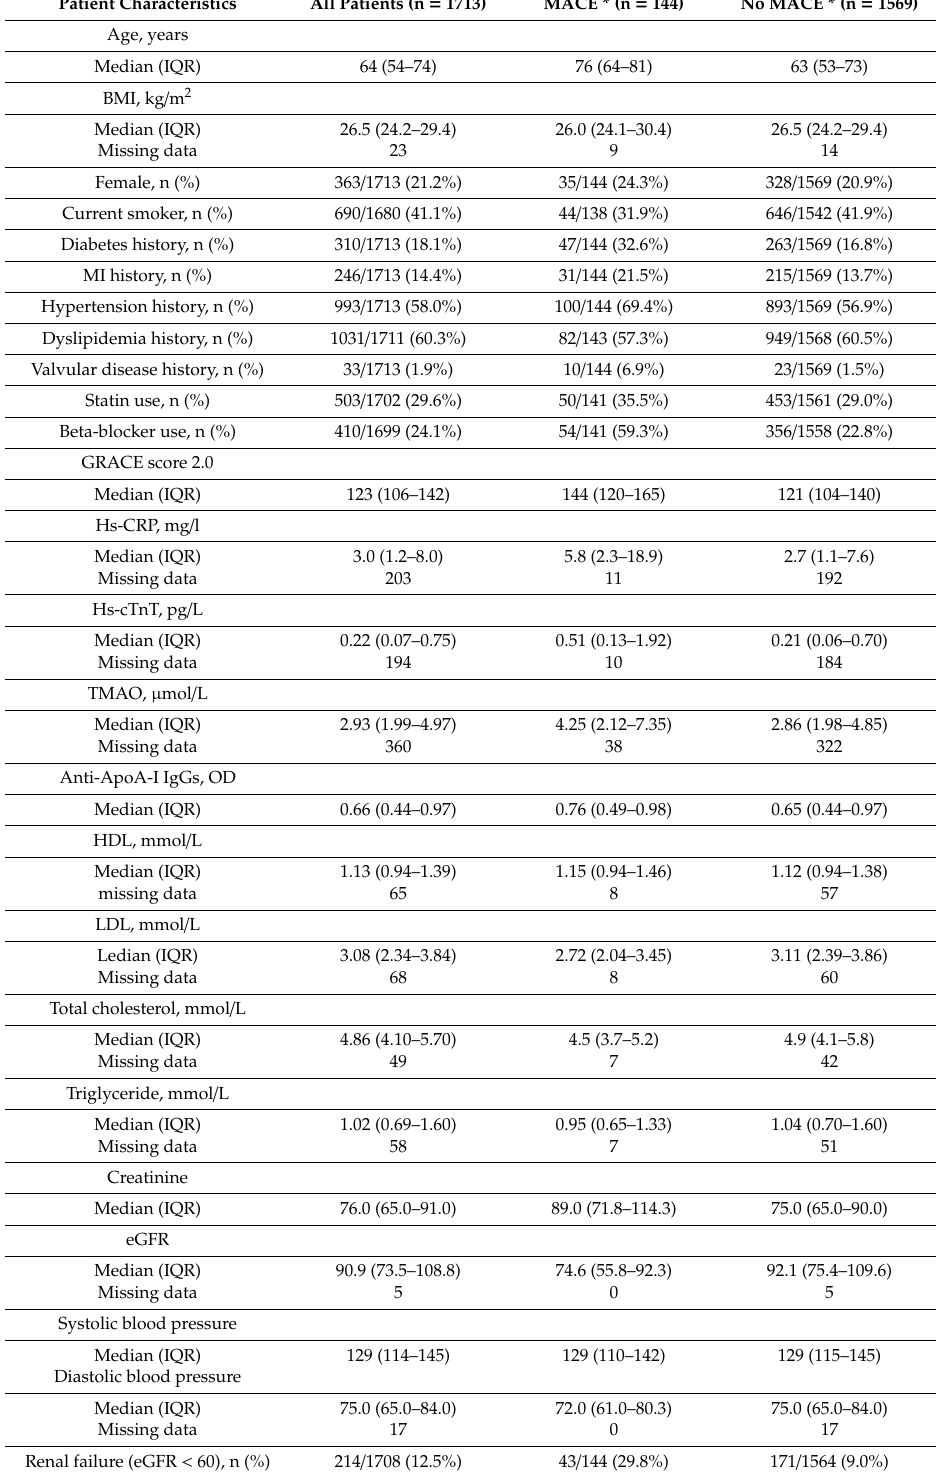
Table 1. Baseline